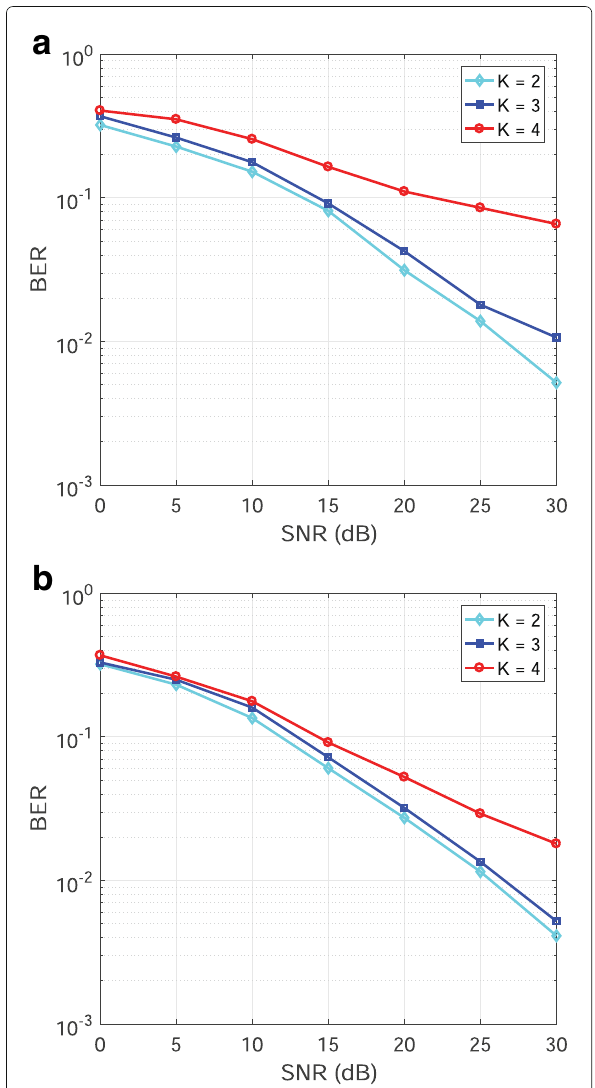
Fig. 7 Performance comparison of proposed method in case of different significant paths of the channel. a BER performance using random pilot allocation and b BER performance using optimized PCE-based pilot allocation